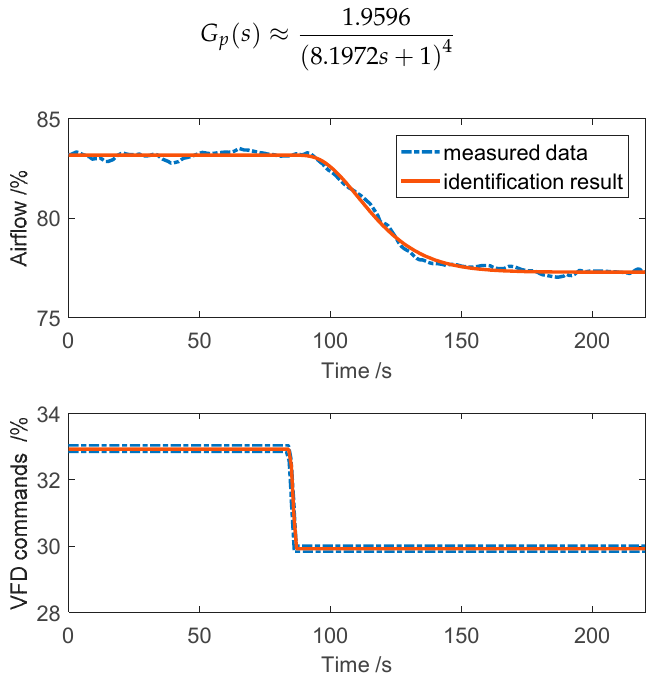
Figure 13. Identification of the secondary air flow control system.